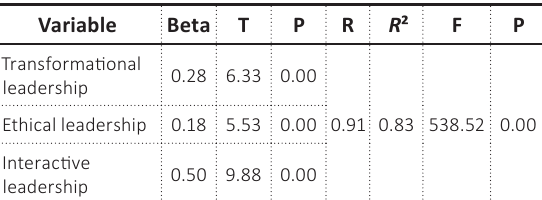
Table 8. The results of applying the multiple regression equation to study the impact of leadership behavior in organizational support